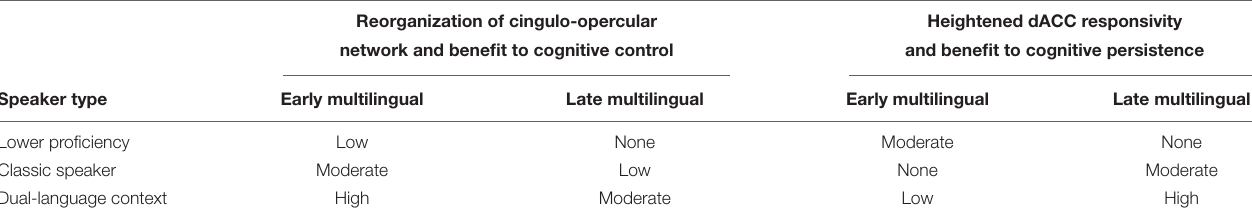
Reorganization of